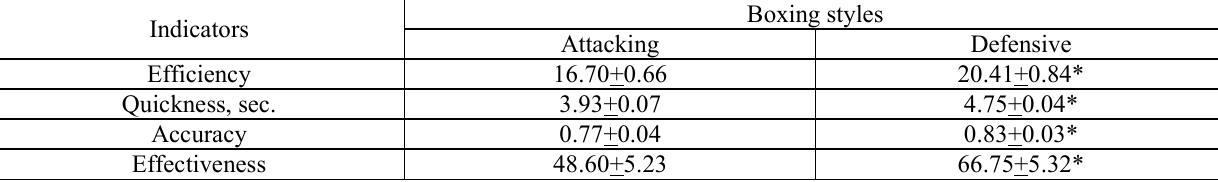
Mean values of test “registration of regularities” of different boxing styles’ boxers. (n=22)